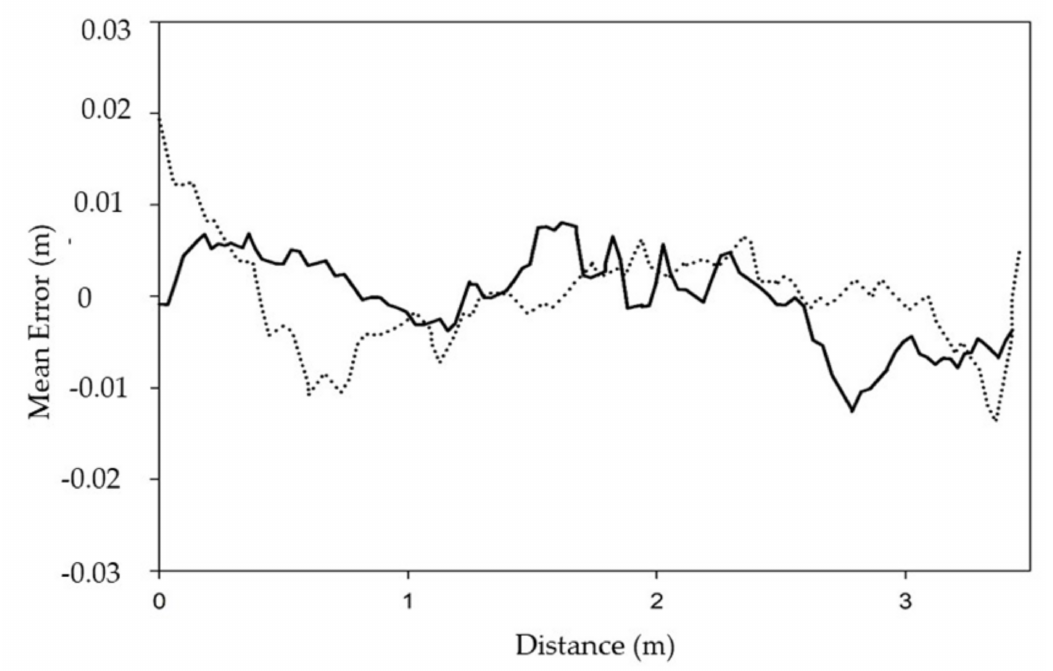
Figure 5. Exemplary variation profile of a measurement track of plot 1 before and after the incorpora- tion of the nonwoven. Profile was measured with the feeler